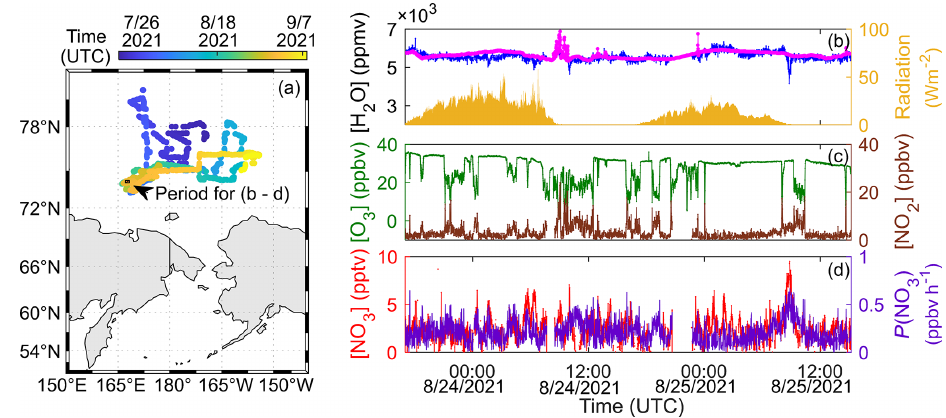
Figure 9. (a) A map with cruise track of R/V Araon and (b–d) representative time series of 1min averaged H 2 O (measured by our instrument on compass deck in blue and a Vaisala instrument on the mainmast in pink), radiation, O 3 , NO 2 , and NO 3 with a calculated production rate of NO 3 for 23 August 2021 at 17:00UTC to 25 August 2021 at 15:10UTC on the open ocean in the Arctic region.